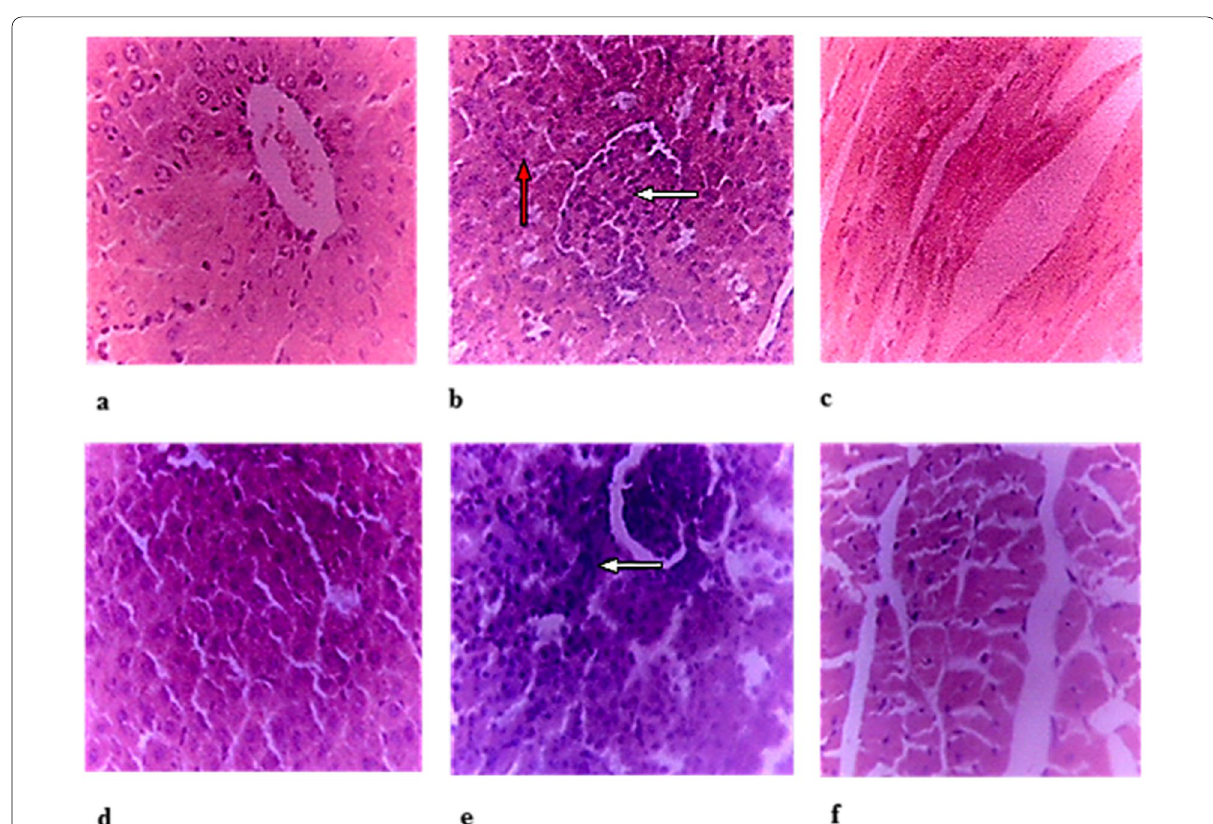
Fig. 2 Photomicrograph of sections of livers, kidneys and hearts of mice. a Liver of control group showing normal hepatocytes, b kidney of control group showing tubules (red arrow) and glomerulus (white arrow). c Heart of control group showing normal cardiac cells. d Liver of ETE (5000 mg/ kg) treated group showing normal hepatocytes, e kidney of ETE (5000 mg/kg) treated group showing moderate lymphocyte hyperplasia (white arrow), f heart of ETE (5000 mg/kg) treated group showing normal cardiac cells, (H&E ×